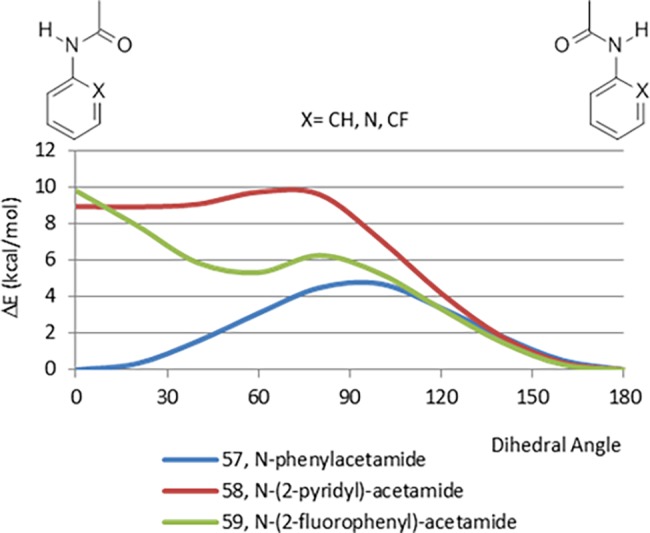
Comparison between CEPs of N-aryl-acetamides.